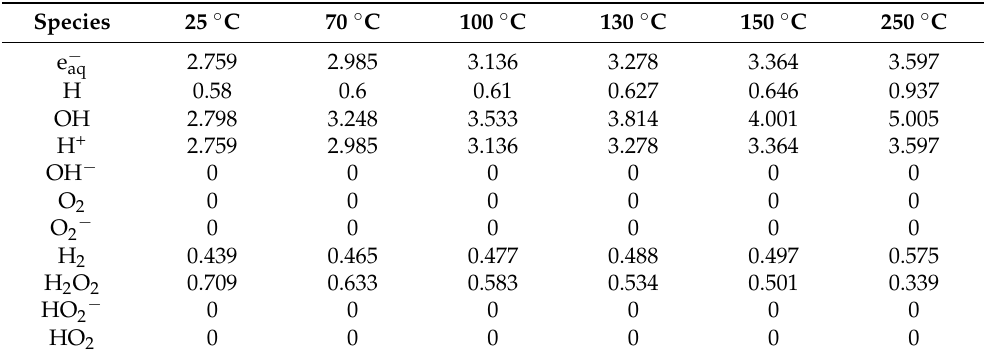
Table 18. Improved G-values (no./100 eV) for low LET (e.g., γ -photon) radiation at different temper- atures (based on data from [60]).